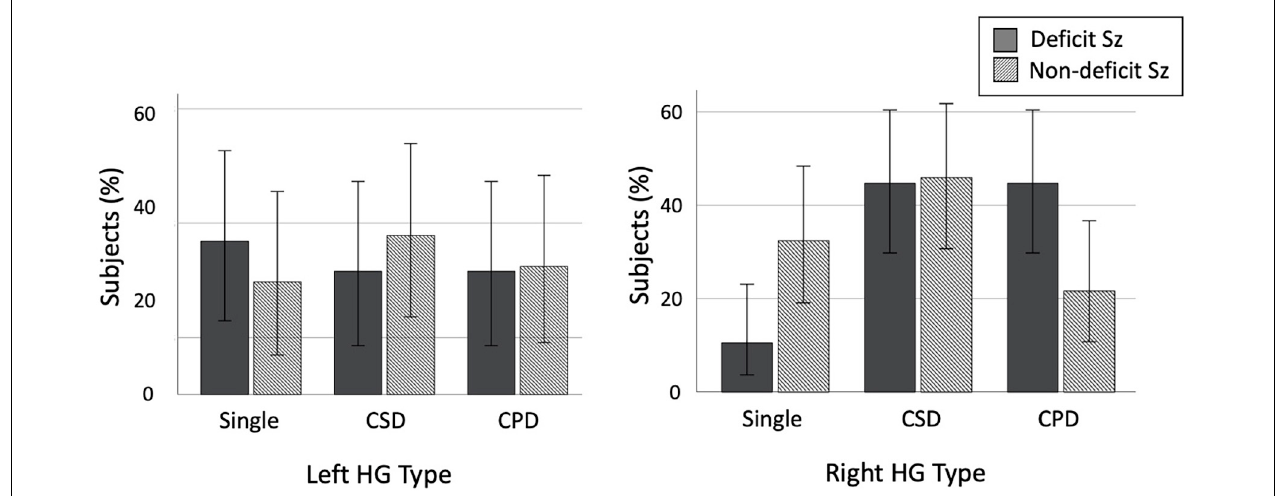
FIGURE 3 | Prevalence of each Heschl’s gyrus (HG) gyrification pattern in patients with deficit and non-deficit schizophrenia (Sz). Error bars indicate 95% confidence intervals. CPD, complete posterior duplication; CSD, common stem